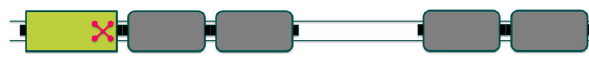
Fig. 4. UAV location art the beginning of maneuvers.